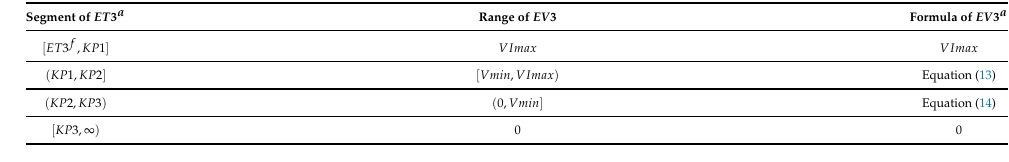
Table 4. Relationship between ET 3 and the maximal EV 3.